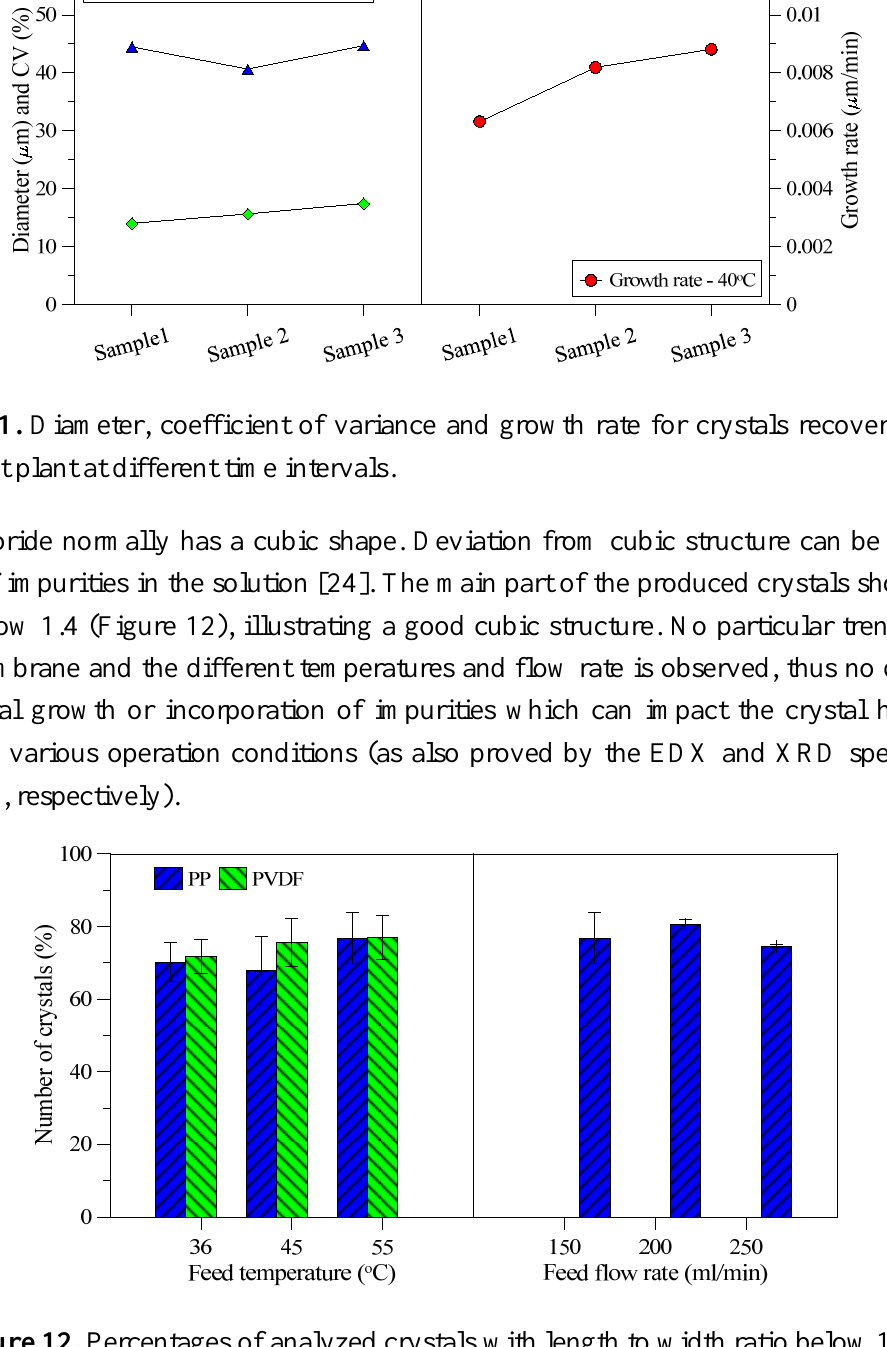
Figure 12. Percentages of analyzed crystals with length to width ratio below